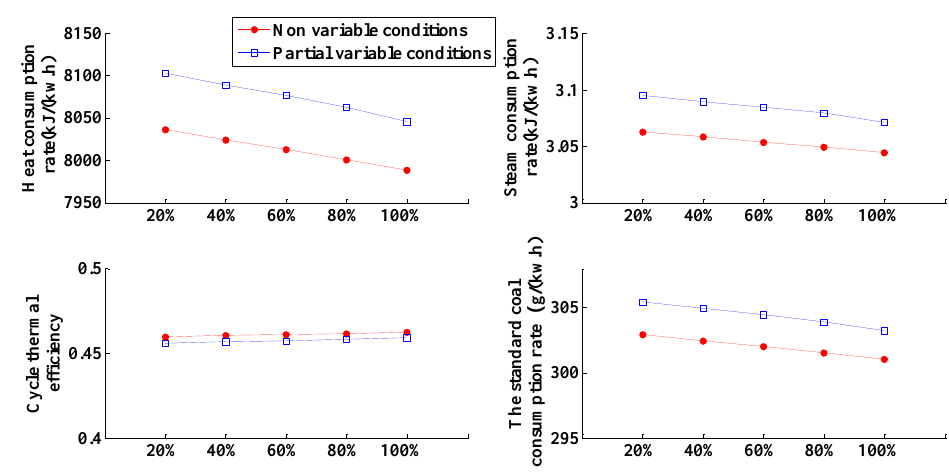
Figure 14. SAPG system 5th thermal economy.